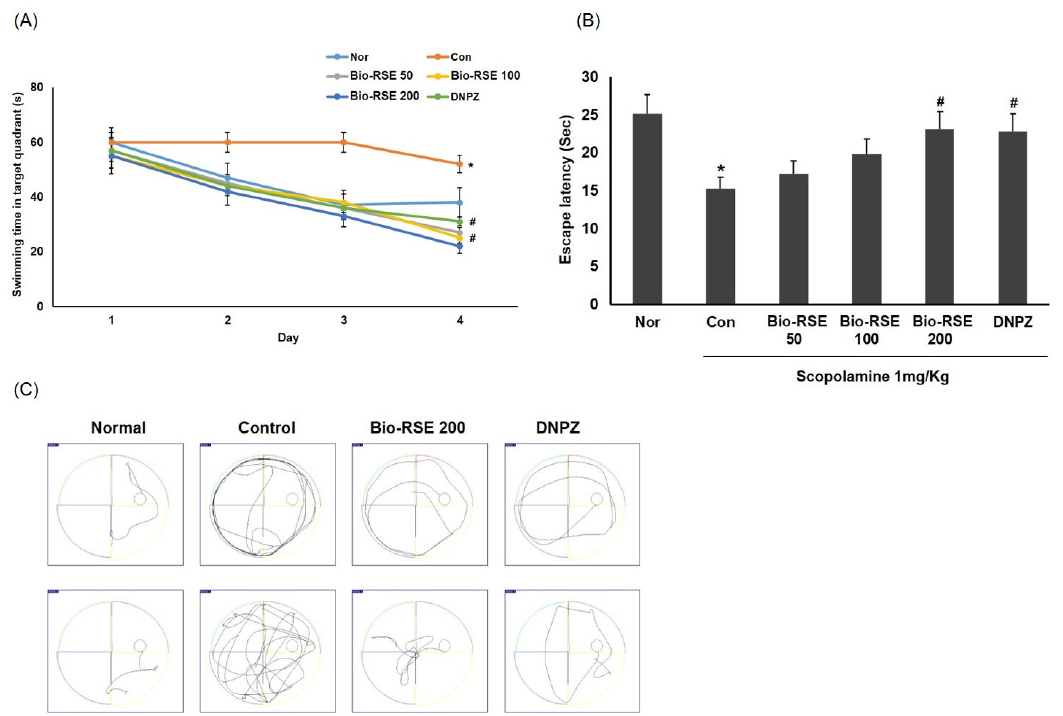
Figure 3. Effect of Bio ‐ RSE on time taken to reach the platform during 4 days in the Morris water maze ( A ). Time to reach the exposed platforms on the final day in the Morris water maze test ( B ). Representative swimming tracking paths in the Morris water maze test ( C ). Values are the mean ± SD. Normal—oral administration of drinking water + 0.9% NaCl i.p.; control—oral administration of